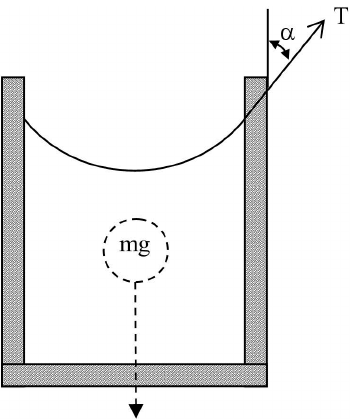
Figure 1. A fluid reservoir filled up to a certain level, the base pressure is determined by the gravitational and capillary forces, and depends on the fluid level.